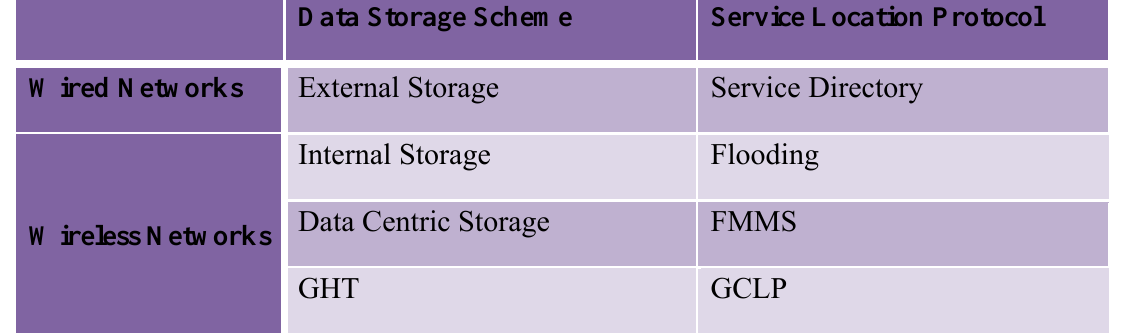
Table 1 . Classification of Data Storage Schemes and Service Location